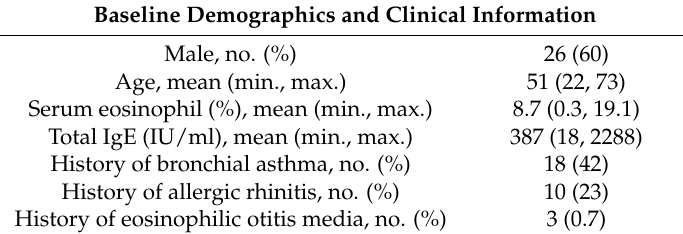
Table 1. Baseline demographics and clinical information ( n = 43